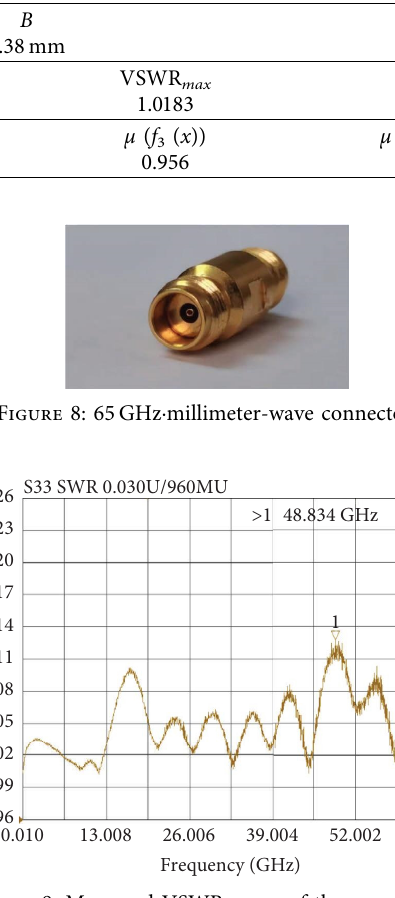
Figure 9: Measured VSWR curve of the connector.